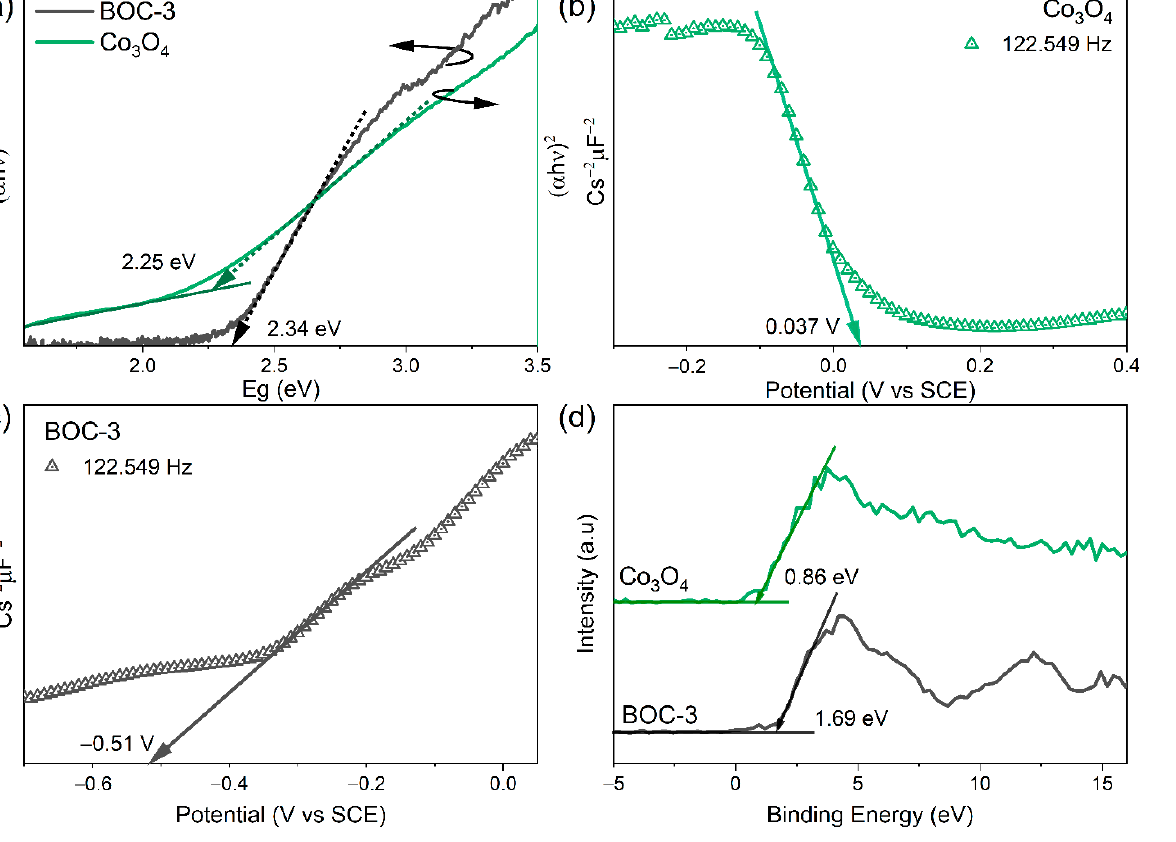
Figure 5. ( a ) Tauc plots, ( b , c ) Mott–Schottky plots, and ( d ) valence band XPS of Co 3 O 4 and